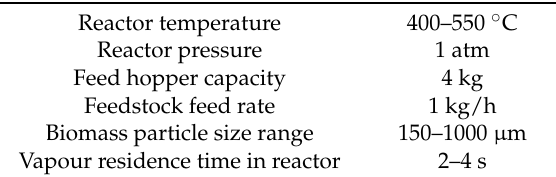
Table 1. Operating Table 1. Operating conditions.